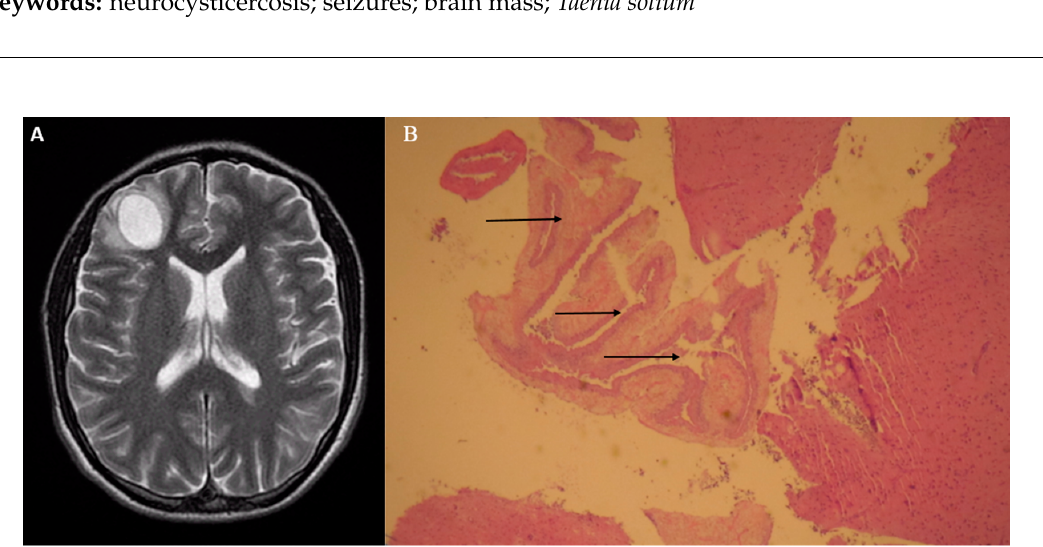
Figure 1. A 24-year old Hispanic man was found unresponsive at home after having multiple episodes of complex partial seizures. He was originally from Mexico and traveled there three weeks prior to hospital admission. His neurological exam did not reveal any focal deficits. He was intubated for airway protection and treated with fosphenytoin. A magnetic resonance imaging (MRI) with gadolinium contrast was ordered. T2-weighted imaging showed a cystic lesion of 2.2 × 2.5 cm in diameter with surrounding edema in right frontal lobe ( A ). Western blot serology for Echinococcus and cysticercosis was negative. Due to the concern for a neoplastic process and negative serology for